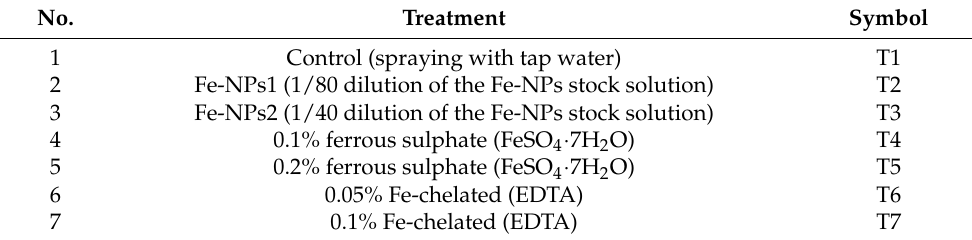
Table 8. The evaluated treatments and their